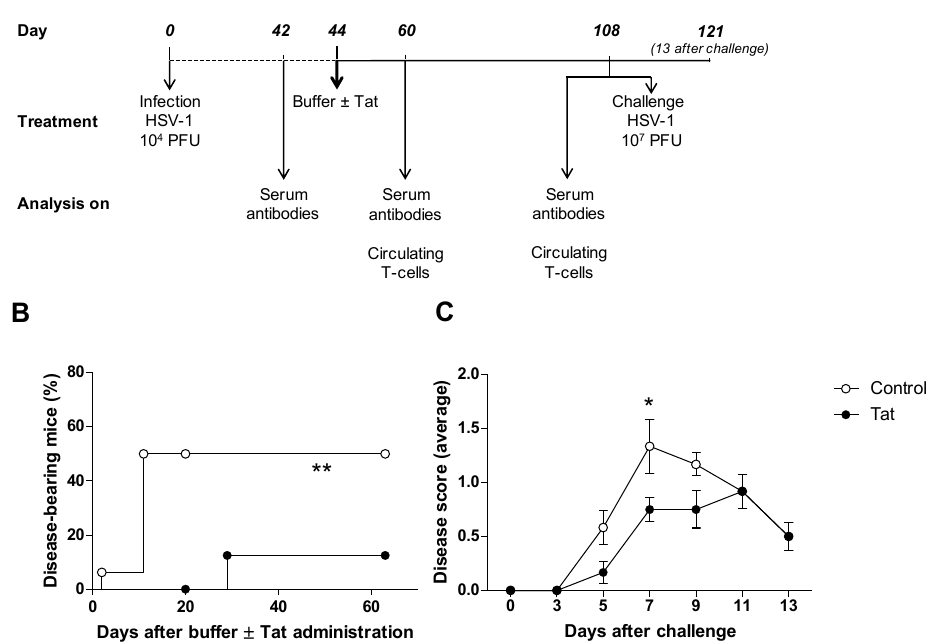
Figure 1. Tat exerts therapeutic e ff ects on previously acquired Herpes Simplex Virus (HSV-1) infection. ( A ) Schematic representation of the experimental protocol and analysis. C57BL / 6 mice were infected by the intravaginal (IV) route with 10 4 plaque forming units (PFU) / mouse of HSV-1 and, on day 44 post-infection (p.i.), treated with HIV-1 Tat (5 µ g) administered by the intradermal (ID) route into the back. Controls were given only the Tat bu ff er. This treatment schedule was repeated in two independent experiments with 16 and 6 mice per group, respectively. Disease scores were monitored up to day 108 p.i. in both experiments. The following treatments and analyses were performed in the second experiment: On day 108 p.i. (i.e., day 64 after bu ff er ± Tat administration), mice were challenged IV with 10 7 PFU / mouse of HSV-1 and observed for two weeks after challenge (day 121 p.i.). Mice were bled on days 42 (before Tat treatment), 60 and 108 (before virus challenge) p.i. to analyze humoral